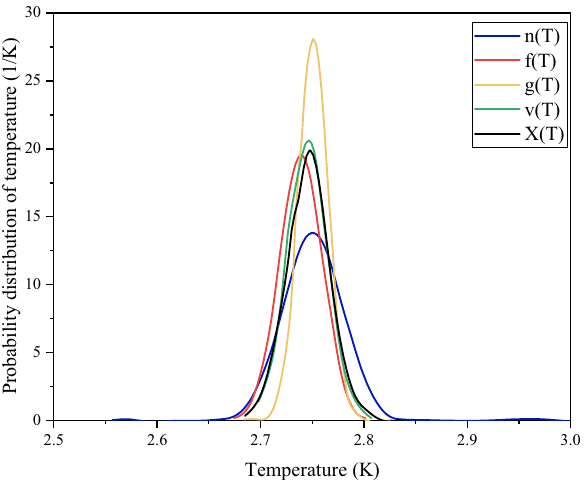
Figure 1. Four different probability functions f(T), v(T), g(T) and n(T) along with their resultant X(T) are plotted against absolute temperature.